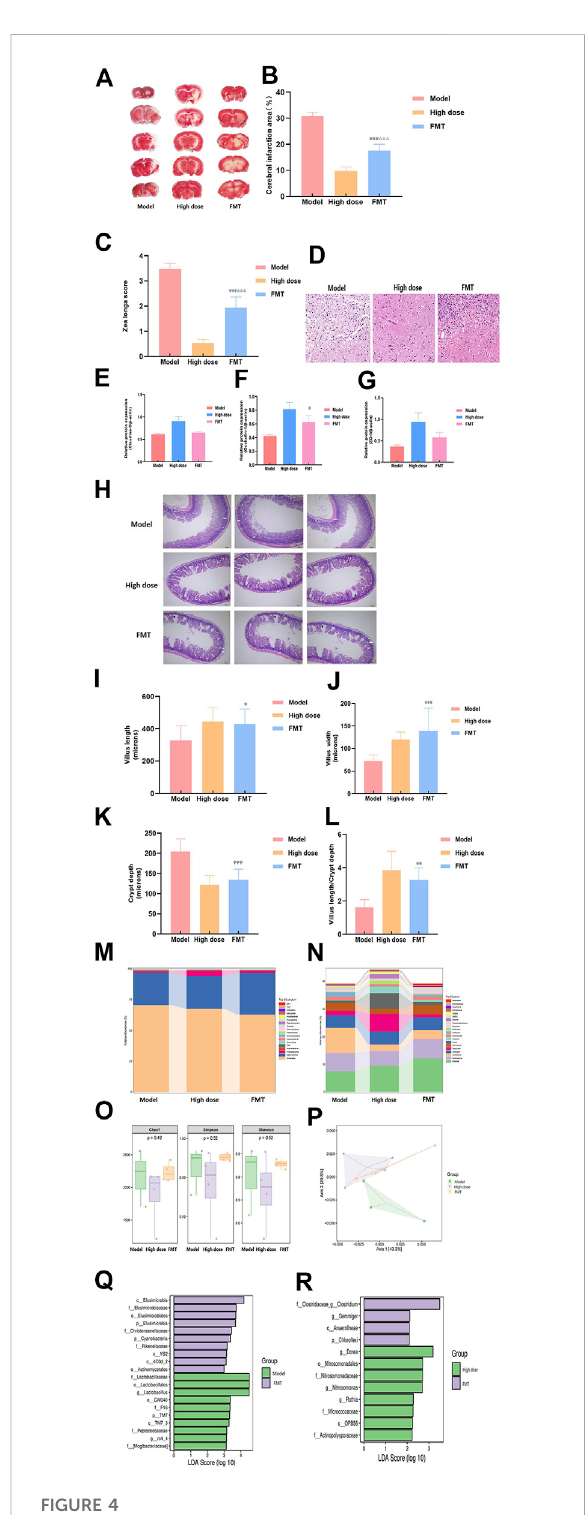
FIGURE 4 FMT reduces stroke damage and alters intestinal fl